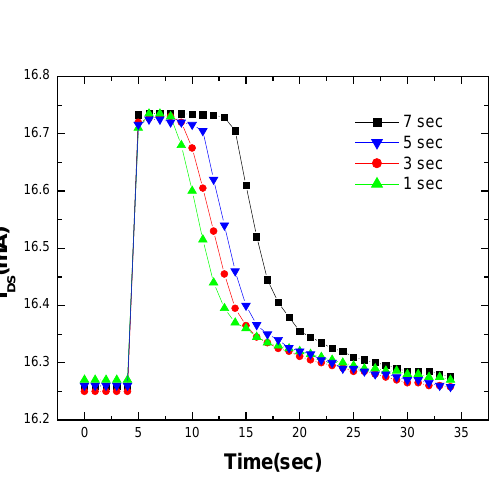
ambient or in 10% 2 /N 2 2